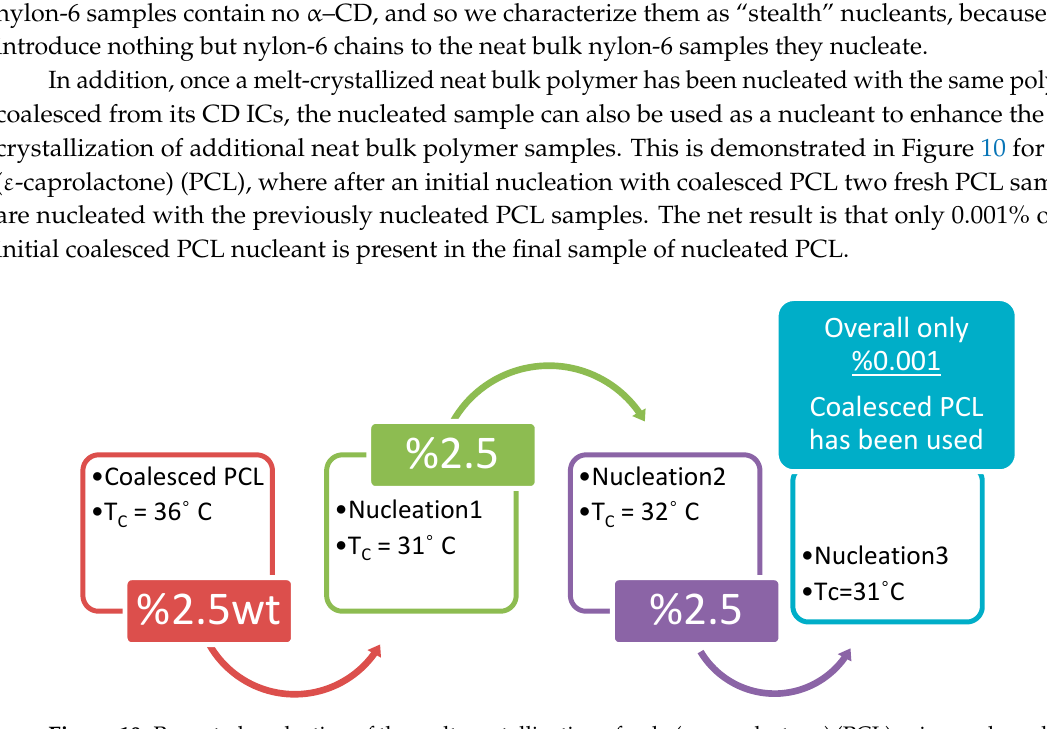
Figure 10. Repeated nucleation of the melt crystallization of poly ( ε -caprolactone) (PCL) using coalesced PCL initially, followed by the repeated use of nucleated PCL to nucleate the melt crystallization of fresh bulk PCL. It should be noted that neat bulk PCL crystallizes at ~11 °C at the same DSC cooling rate of 20 °C/min.